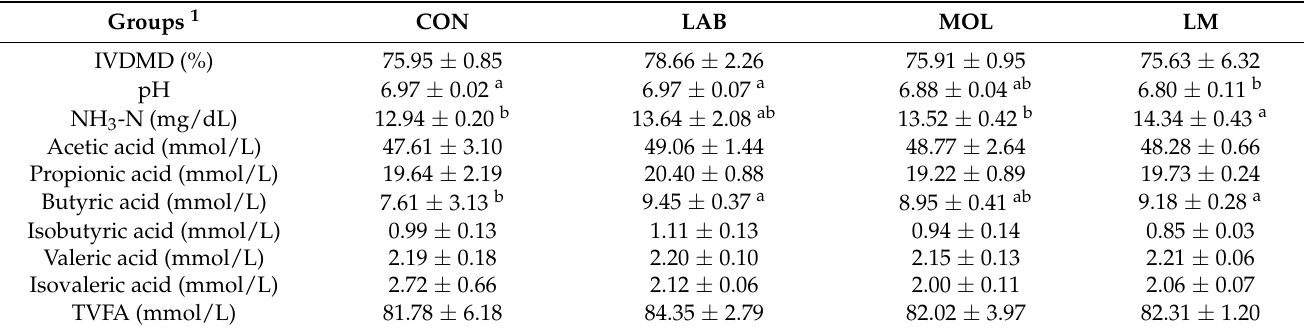
Table 3. Effects of paper mulberry silage treated with different additives on the in vitro degradability of DM, ruminal liquid pH, VFAs, and ammonia after 48 h of